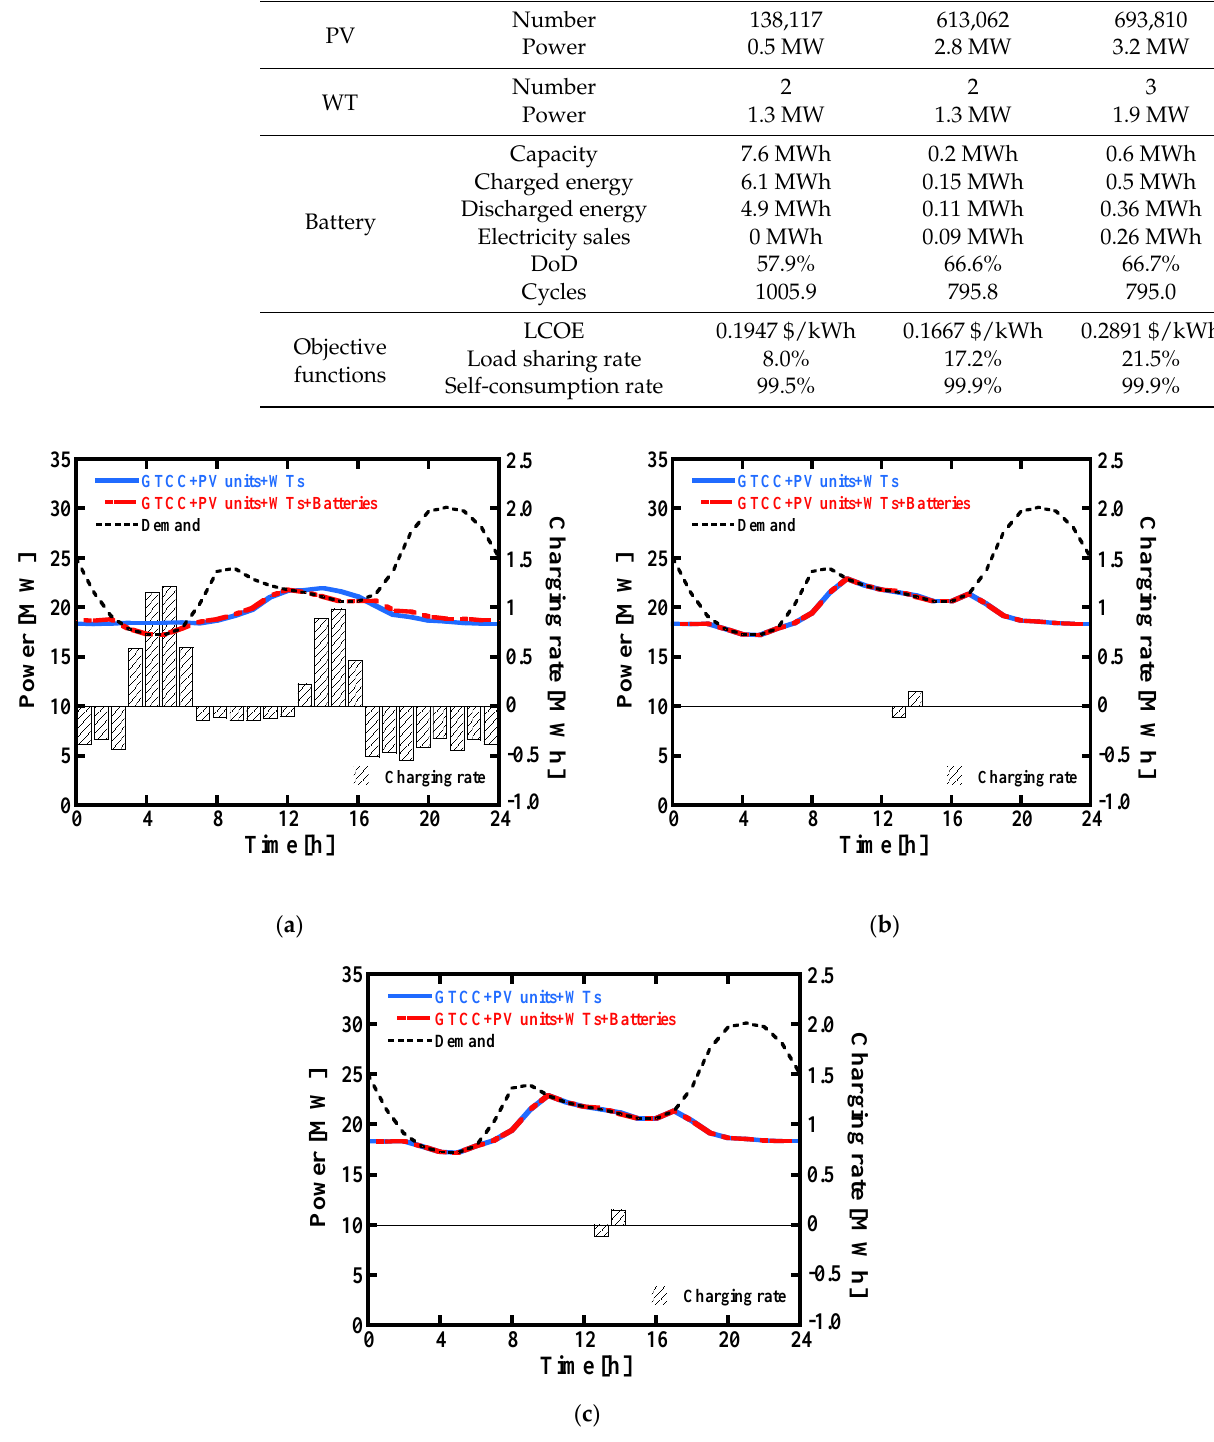
Figure 15. Results of operation strategy according to the gas turbine operation modes: ( a ) Case 1; ( b ) Case 2; ( c ) Case 3. In case 1, the 15-MW GT operates under full load all the time. To meet the electricity demand, 138,117 PV units (7.6 MW) and 2 WTs (6 MW) must be installed. However, dur- ing the daytime, the average capacity factor of the PV was 8.6%, and the capacity factor of the WT was 21.4%, so the power generated from RE was about 0.5 MW for the PV units and 1.3 MW for the WTs on average. The load-sharing rate based on the output of the RE was 8.0%. The battery capacity in case 1 was 7.6 MWh because only the battery was used as a flexible resource. The DoD and cycles of the batteries were 57.9% and 1005.9 cycles. Due to the large capacity of the batteries, LCOE was relatively high at 0.1947 $/kWh. The bat- teries were charged with 6.1 MWh of electricity for 8 h, and 4.9 MWh of electricity was discharged for 16 h when the power demand was insufficient. In case 2, the 15-MW GT ran at partial load. In this case, since the GT and battery were flexible resources, the required number of PV units was 613,062 (32.5 MW), and the required number of WTs was 2 (6 MW). The average power generation of the PV and WT was about 2.8 MW and 1.3 MW, respectively. Unlike case 1, the amount of power generated from the GT was adjusted to match the power demand at 3:00–6:00 and 13:00–16:00 when the power demand was low. In par- ticular, since the turn-down ratio of the GT was set to 50% of its rated power, the RE ca- pacity could be increased, while the capacity of the batteries could be kept low. The load-